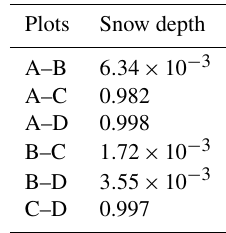
Figure 5. Box plots of (a) snow depth, (b) elevation and (c) micro- topographic elevation in plots A–D. Table 3. p values from Tukey’s pairwise comparison test for each pair of the plots.